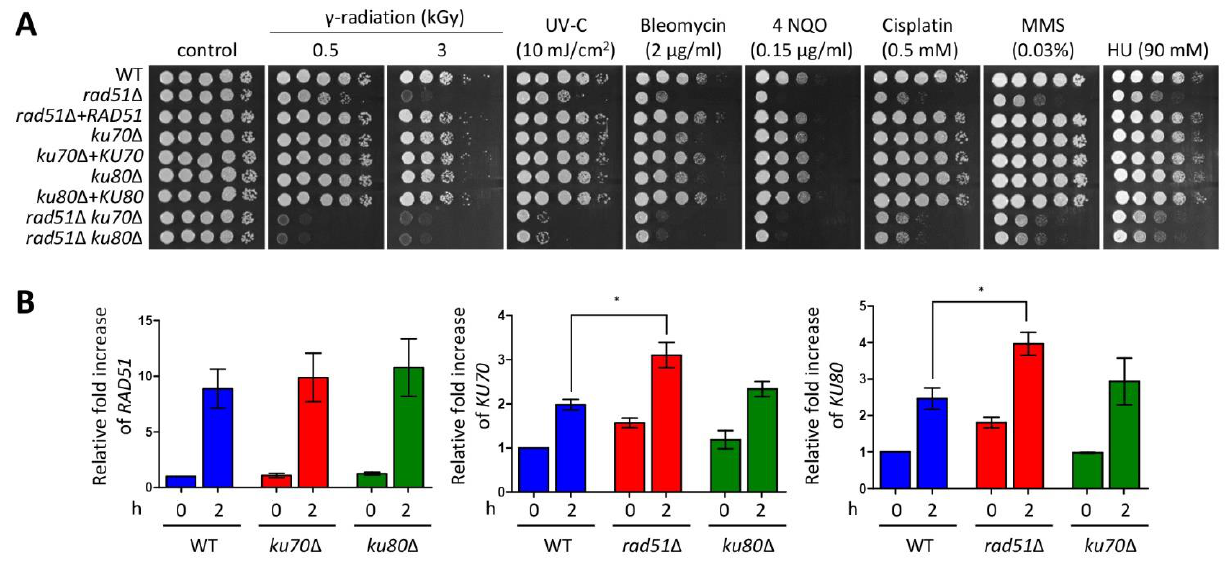
Figure 2. Rad51-mediated homologous recombination (HR) plays a major role in DNA repair. ( A ) Each Cryptococcus neoformans strain was cultured in liquid YPD medium for 16 h at 30 ◦ C. The grown cells were serially diluted (1 to 10 4 ) and then spotted on a YPD plate containing the indicated concentrations of DNA damage insults. For the gamma radiation and UV-C resistance test, the serially diluted cells spotted on the solid YPD plates were exposed to gamma radiation and UV-C. Strains were further incubated for 1 to 3 days at 30 °C and photographed daily. ( B ) The expression of KU70 and KU80 genes was higher in the rad51 Δ mutant in response to bleomycin than that in the wild type (WT). Total RNA was isolated from the WT strain treated with the indicated concentration of bleomycin (2 µ g/mL) for 2 h, and cDNA was synthesized from these total RNA samples. Three independent experiments were performed in duplicate. Statistical significance of difference was determined by one-way analysis of variance (ANOVA) with Bonferroni’s test. Error bars indicate standard errors of means (* p < 0.05).